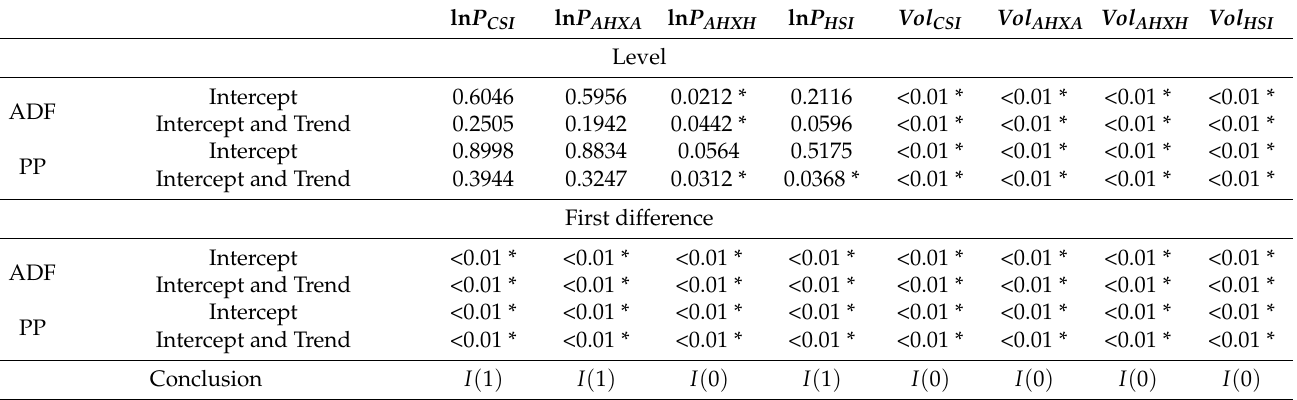
Table 3. Results of unit root